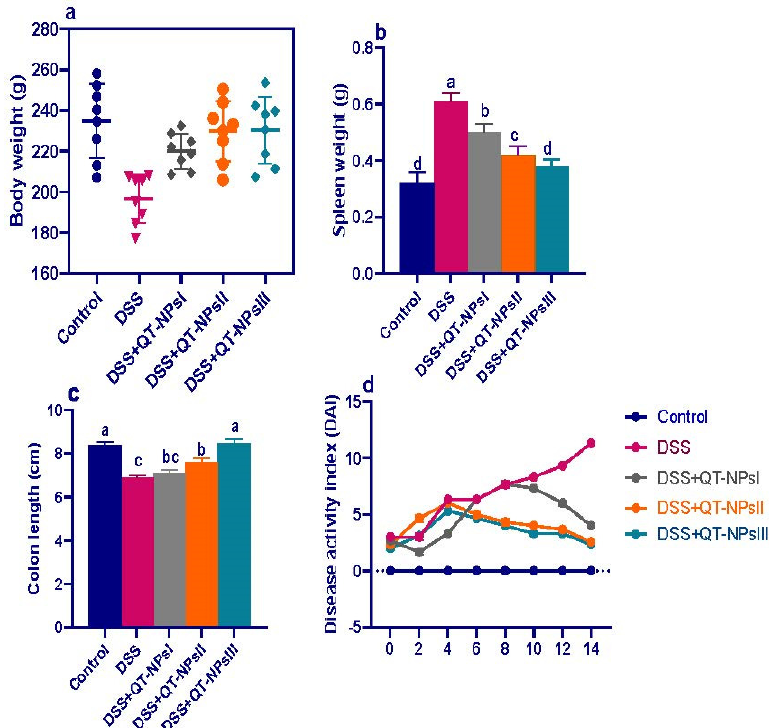
Figure 2. Impacts of quercetin-loaded nanoparticles (QT-NPs) therapy on colitic signs. ( a ) Body weight gain. ( b ) Spleen weight, ( c ) colon length, ( d ) disease activity index score. Control: healthy non-colitic group (rats orally gavaged with PBS); colitic groups: DSS (rats orally gavaged with dextran sodium sulphate), DSS + QT-NPsI (rats orally gavaged with DSS and quercetin-loaded nanoparticles (QT-NPs at the level 10 mg/kg body weight for 14 days)), DSS + QT-NPsII (rats orally gavaged with DSS and quercetin-loaded nanoparticles (QT-NPs at the level 15 mg/kg body weight for 14 days)), DSS + QT-NPsIII (rats orally gavaged with DSS and quercetin-loaded nanoparticles (QT-NPs at the level 20 mg/kg body weight for 14 days)). All groups were orally gavaged by 3% DSS. a–d Means of the rows with different letters were significantly different among groups ( p < 0.05).